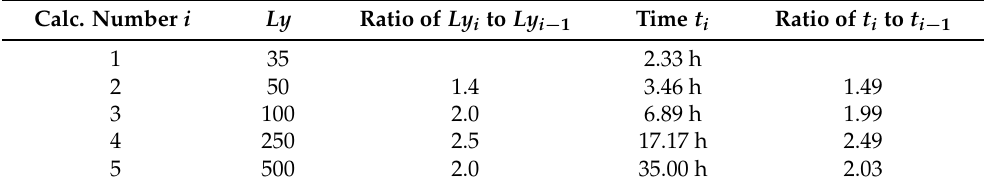
Table 2. Performance of the parallel algorithm of fbc spin lattice calculation for 35 × 35, 50 × 35,